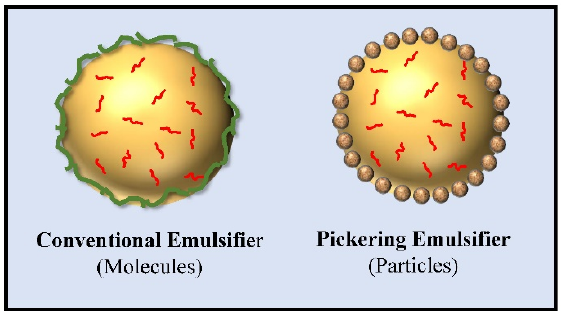
Figure 1. Emulsion stabilization mechanisms: molecular versus particle emulsifiers.